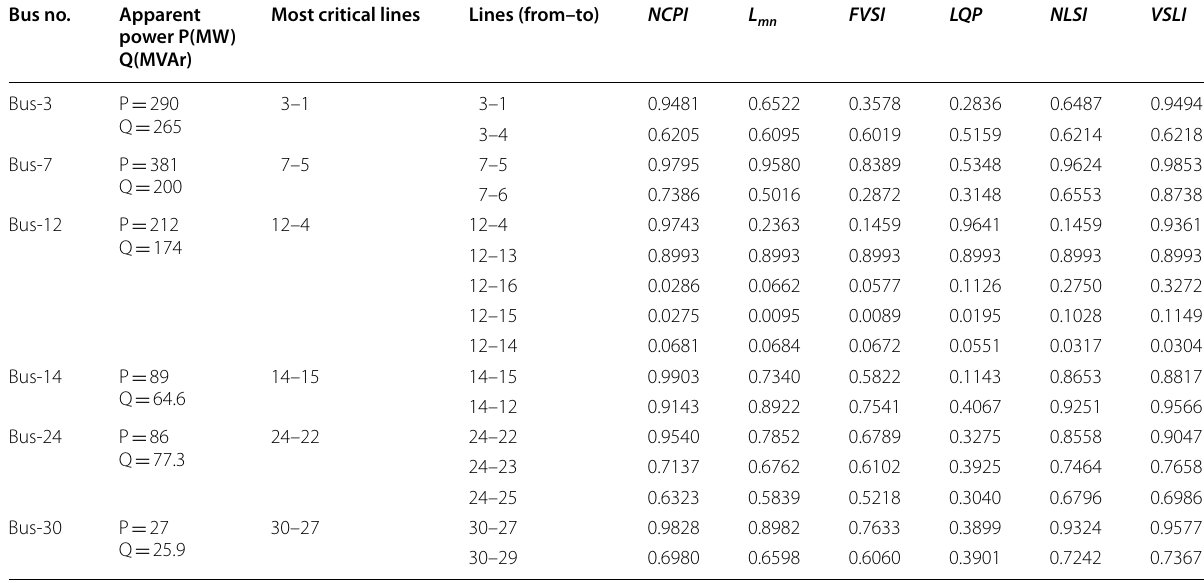
Table 4 Heavy active and reactive power at some load buses of the IEEE 30-bus test system Bus